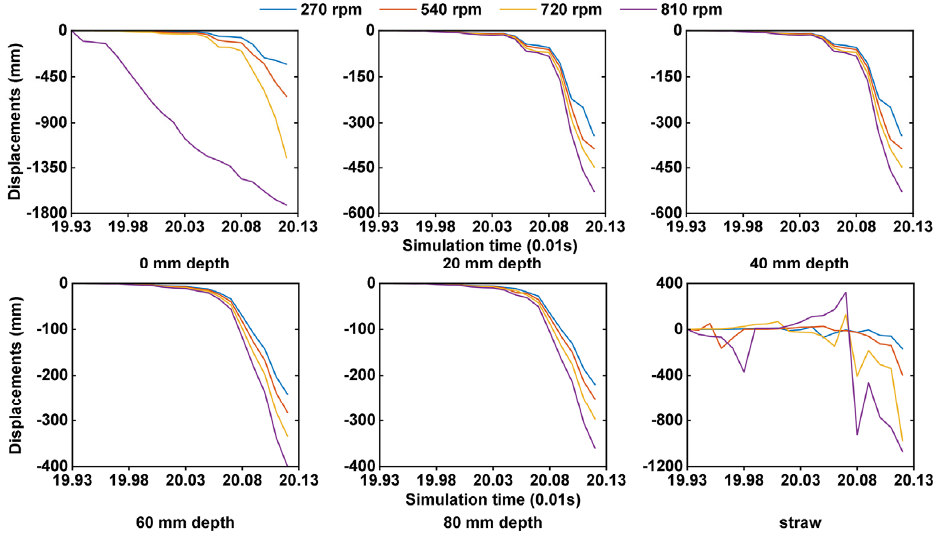
Figure 9. Longitudinal displacements of soil particles at different depths and surface straws at different rotary speeds.